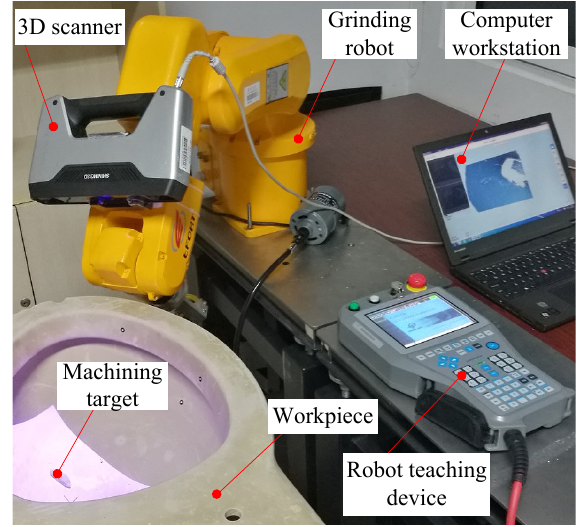
Figure 6. Experimental scenario for detecting the machining target using the 3D vision system.